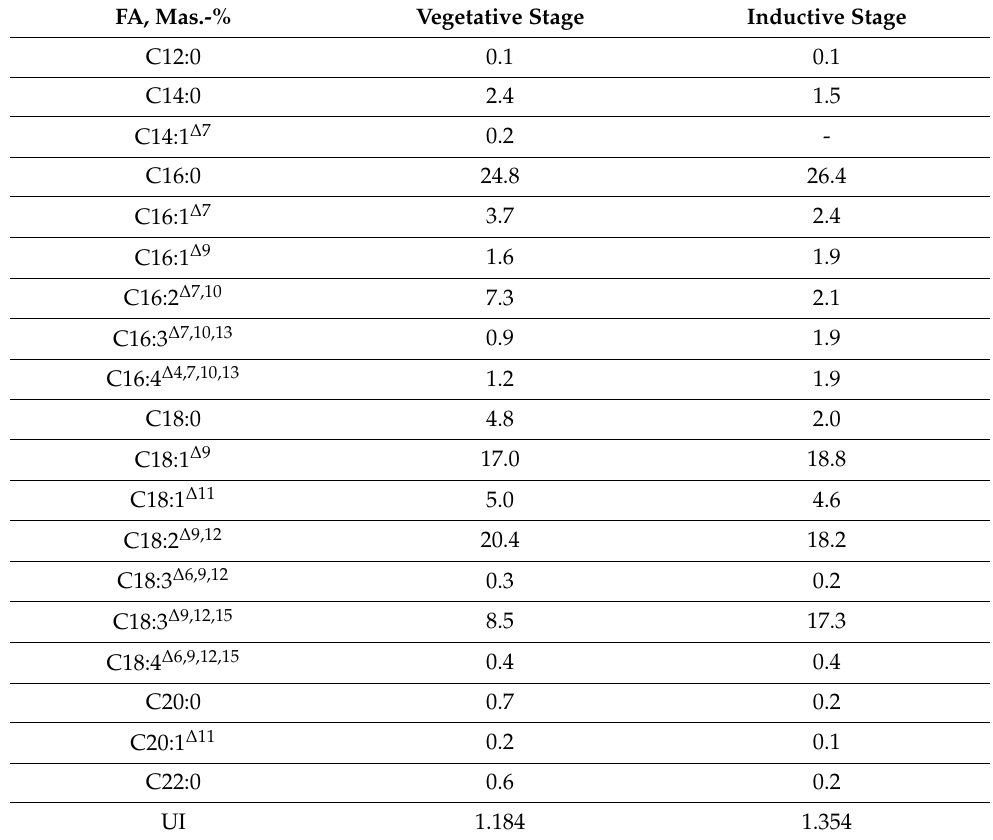
Table 3. Fatty acid profile of Bracteacoccus aggregatus BM5/15 biomass and calculated values of the unsaturation index (UI). FA, Mas.-% Vegetative Stage Inductive